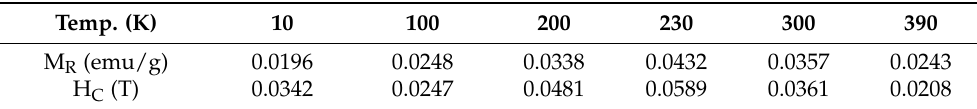
Figure 5. ( a ) Monitoring CR dye sodium salt and protonated structure in LC–MS. ( b ) Absorbance spectra of CR in the presence of IONPs. ( c ) Absorbance spectra in visible light in the absence of IONPs. Table 2. M R and H C of the IONPs at various temperatures. Temp.